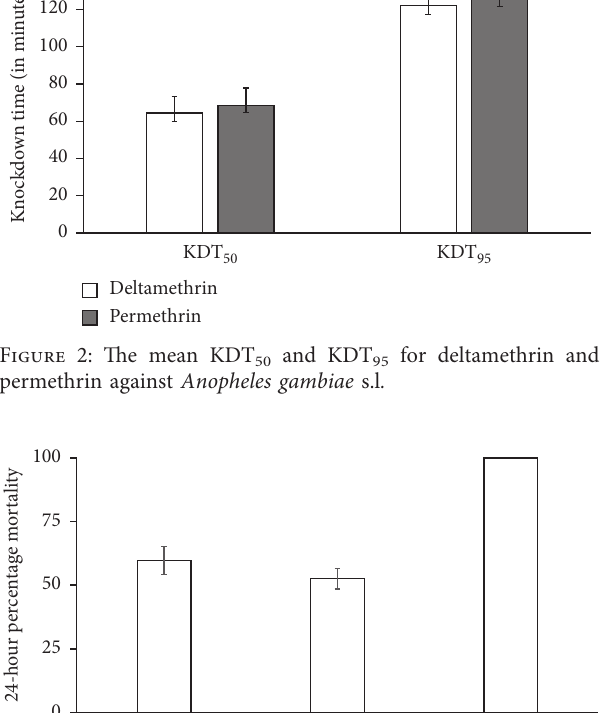
Figure 5: The feeding succession of Anopheles gambiae s.s. (Kisumu susceptible strain) and An. gambiae s.l. (wild resistant